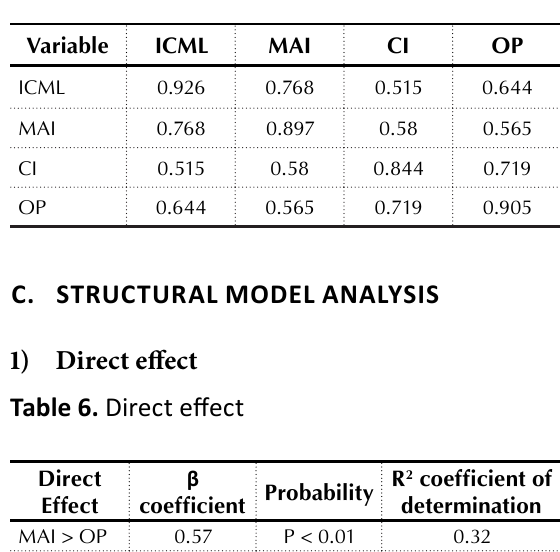
Table 5. Discriminant validity